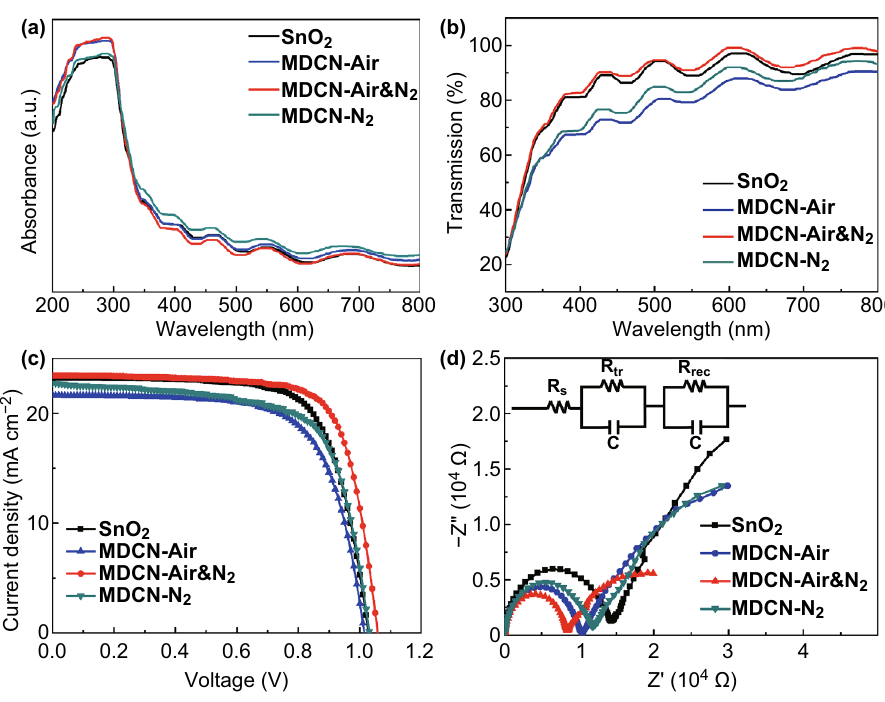
Fig. 7 a UV–Vis absorption spectra and b transmission spectra for SnO 2 , MDCN‑Air, MDCN‑Air&N 2 , and MDCN‑N 2 ETLs. c J − V curves and d Nyquist plots of EIS for PSCs using SnO 2 , MDCN‑Air, MDCN‑Air&N 2 , and MDCN‑N 2 ETLs. The equivalent circuit of d shown in